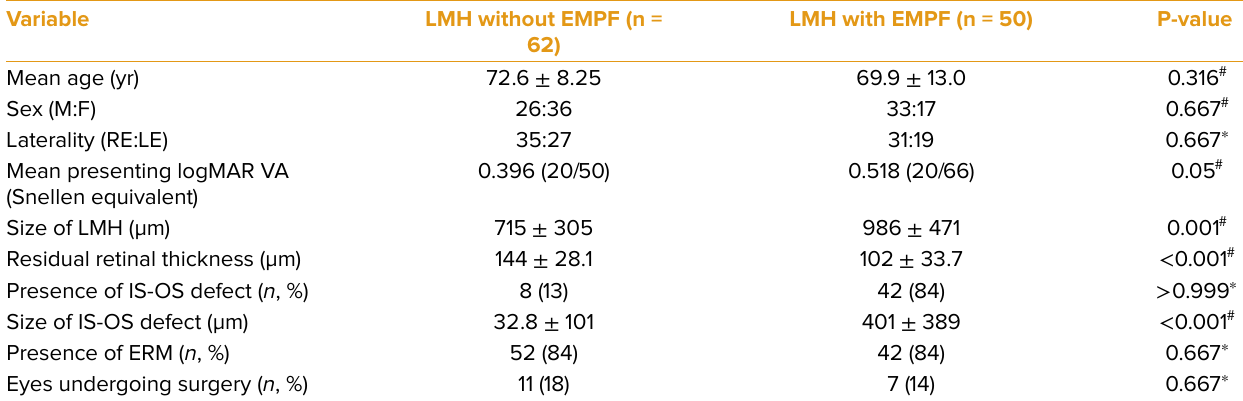
Table 1. Clinical and optical coherence tomography findings of patients with and without EMPF in eyes with LMH Variable LMH without EMPF (n = LMH with EMPF (n = 50) P-value 62) Mean age (yr) 72.6 ± 8.25 69.9 ± 13.0 0.316